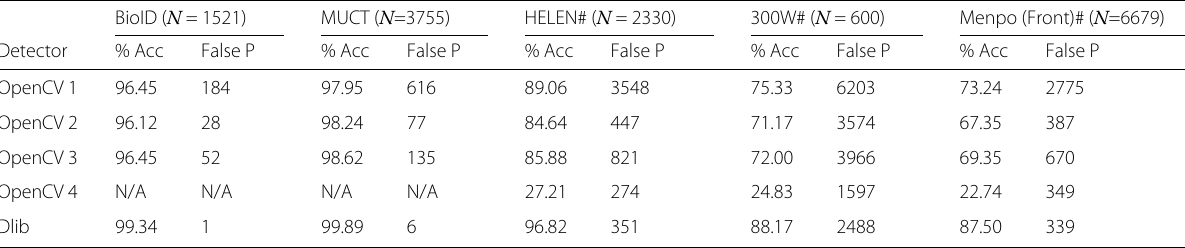
Table 2 ‘Off-the-shelf’ frontal face detector